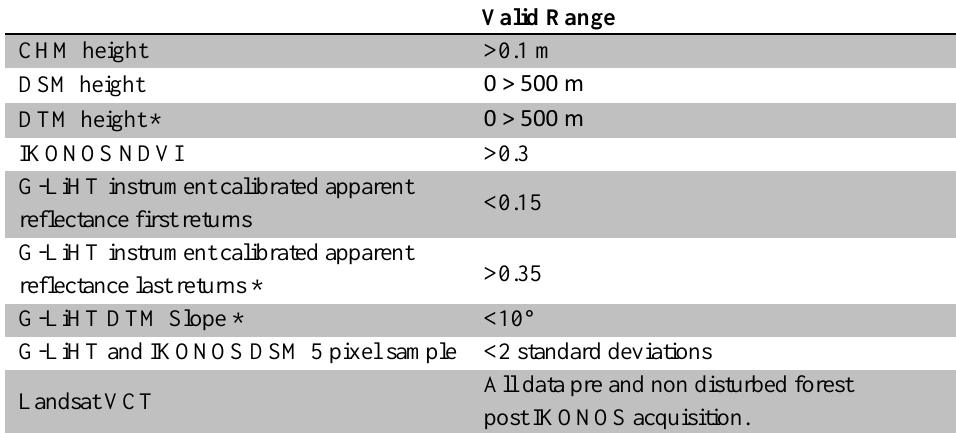
Table 2. G-LiHT, IKONOS, and Landsat valid data ranges for DTM, digital surface model (DSM), and CHM